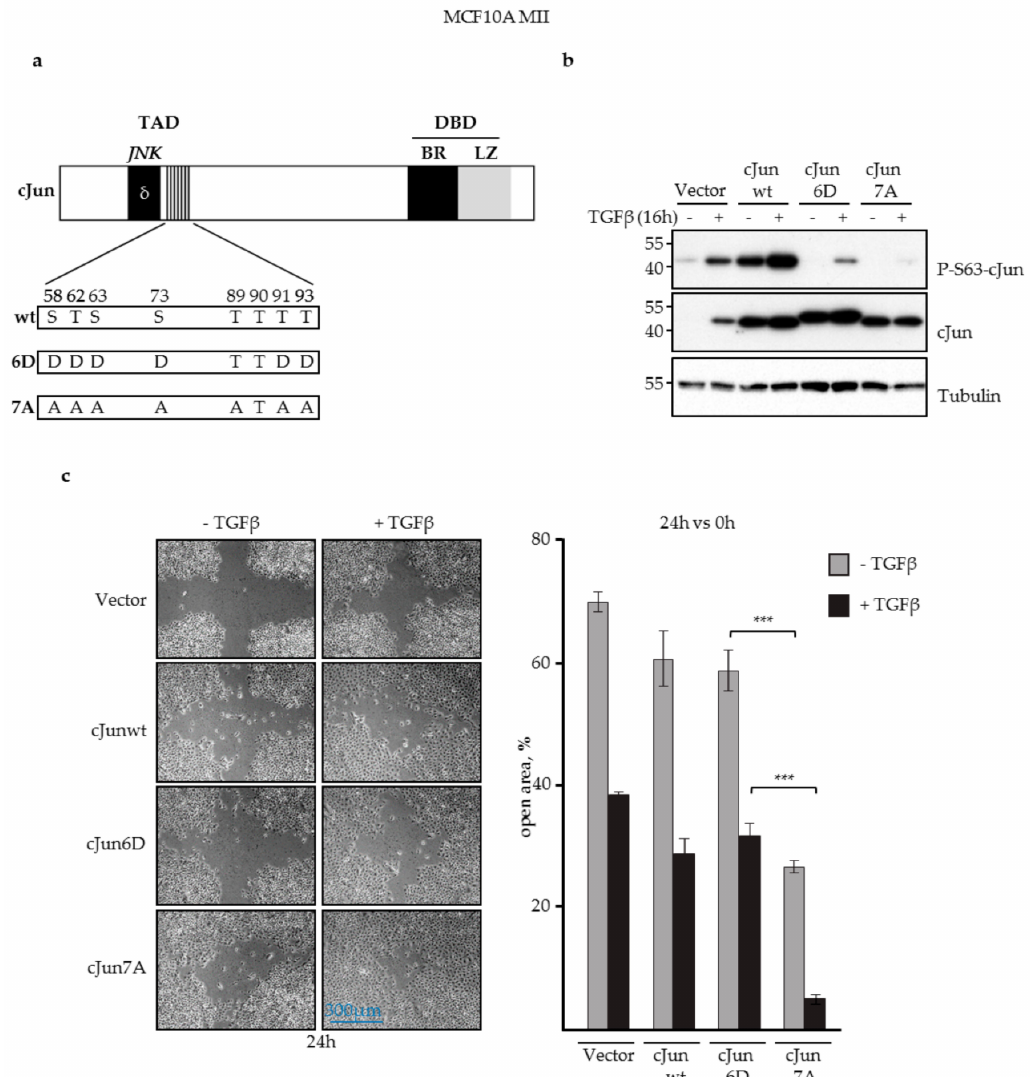
Figure 1. JNK-dependent phosphorylation of cJun negatively a ff ected MCF10A MII cell migration. ( a ) Schematic representation of cJun showing the known and potential N-terminal JNK phosphorylation sites and the changes in the 7A loss-of-function and 6D gain-of function mutants. TAD, transactivation domain; DBD, DNA-binding domain; δ , JNK docking site; BR, basic region; LZ, leucine zipper. Numbers correspond to serine / threonine phosphorylation sites in the TAD; ( b ) Immunoblot analysis of P-S63-cJun and cJun upon stable lentiviral overexpression of cJun wild-type (wt), cJun-6D, and cJun-7A in MCF10A MII cells cultured in the presence of EGF and treated with 5 ng / mL TGF β for 16 h, as indicated. Tubulin was analyzed as loading control; ( c ) Migration (% open area) of the MCF10A MII cells stably overexpressing wt cJun as well as cJun-6D and cJun-7A mutants, in the presence or absence of TGF β (5 ng / mL) for 24 h, as measured by wound healing assays; *** p <